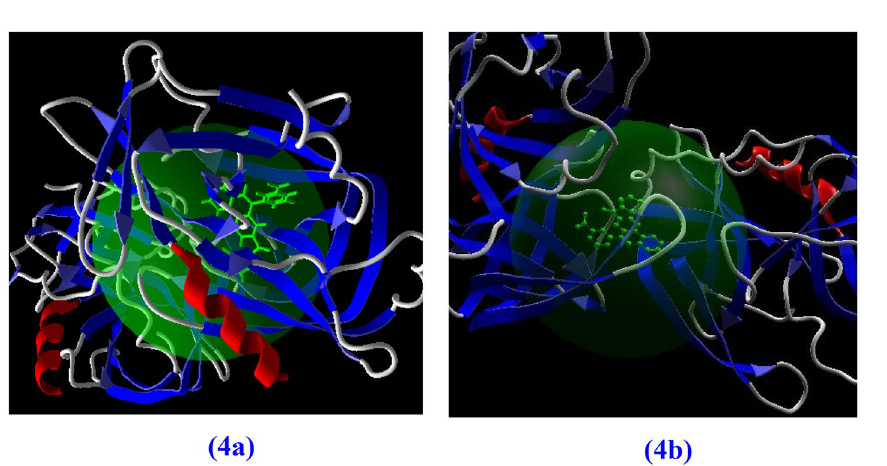
Figure 3. Molecular simulation of the 4a, 4b, and Hepatitis